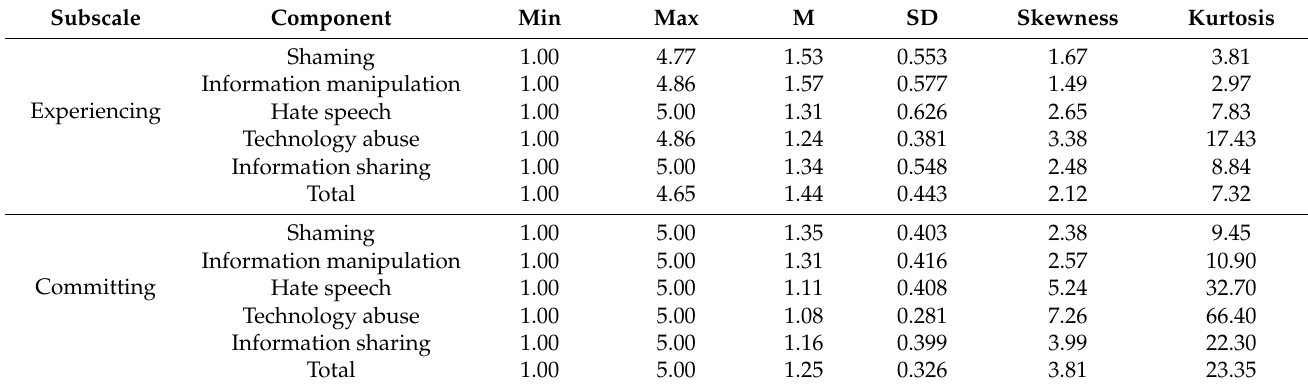
Table 7. Descriptive statistics of Experiencing and Committing